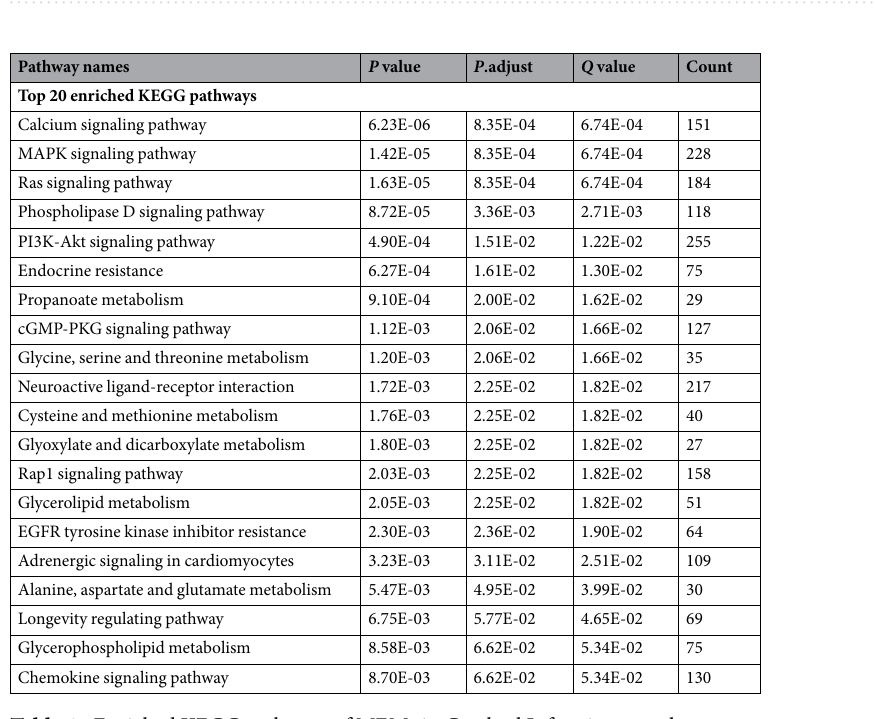
Table 4. Enriched KEGG pathways of MEMs in Cerebral Infarction